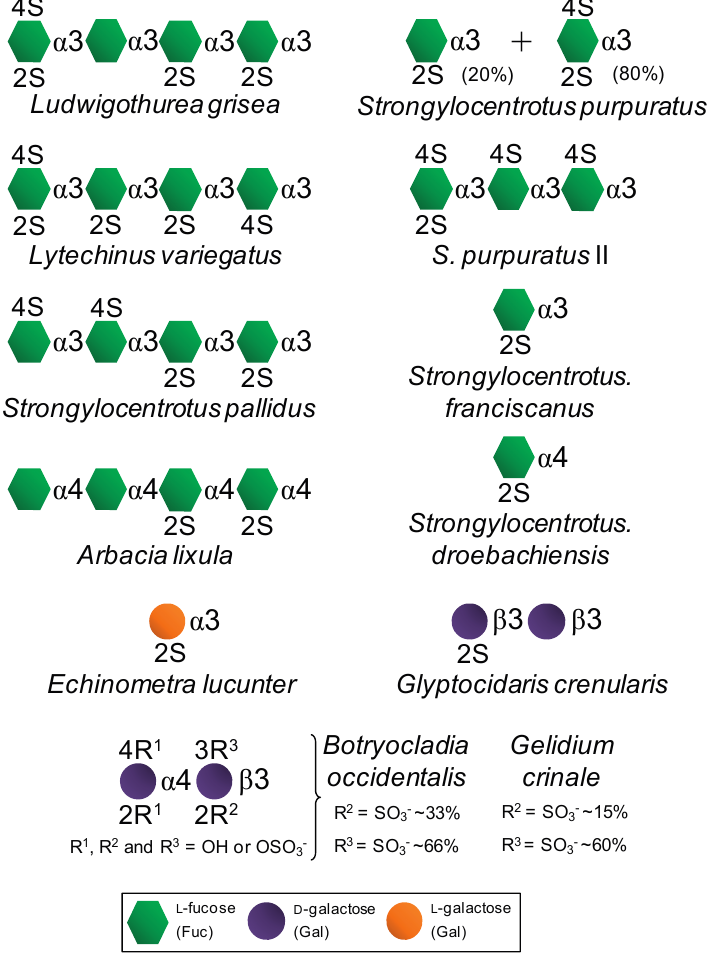
Figure 2. Structural representation of the marine, invertebrate and red algal, SFs and SGs of well-defined chemical structures. All species are sea urchins, except the first one which is a sea cucumber and the last two which are red